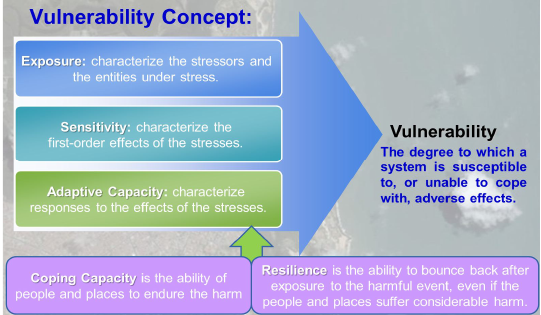
Figure 1. Vulnerability concept (Mukesh Boori PhD